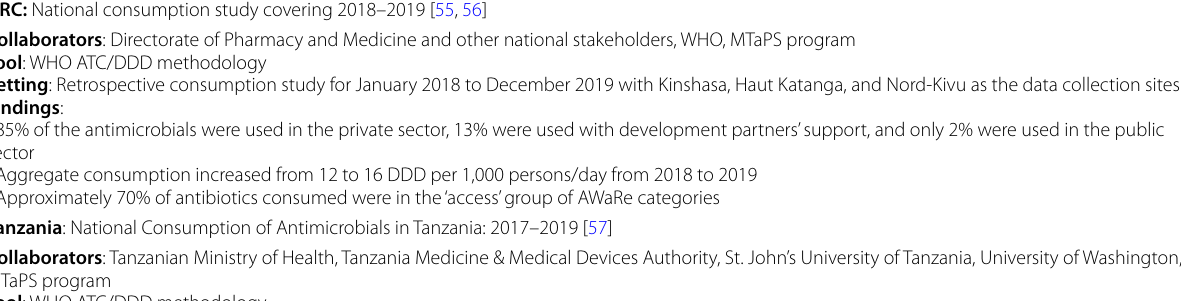
Table 7 Studies conducted to generate reliable data on antimicrobial consumption and use DRC: National consumption study covering 2018–2019 [55, 56] Collaborators : Directorate of Pharmacy and Medicine and other national stakeholders, WHO, MTaPS program Tool : WHO ATC/DDD methodology Setting : Retrospective consumption study for January 2018 to December 2019 with Kinshasa, Haut Katanga, and Nord-Kivu as the data collection sites Findings